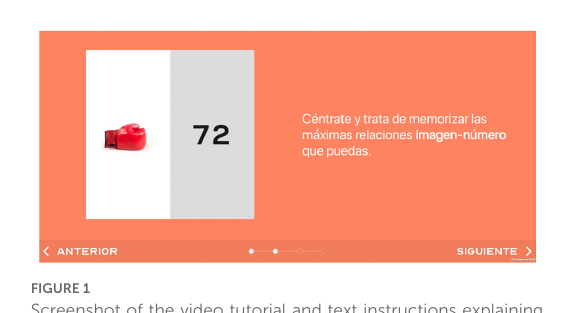
FIGURE1 Screenshot of the video tutorial and text instructions explaining task’s logic; the user can move forward ( Siguiente ) and backwards ( Anterior ) if